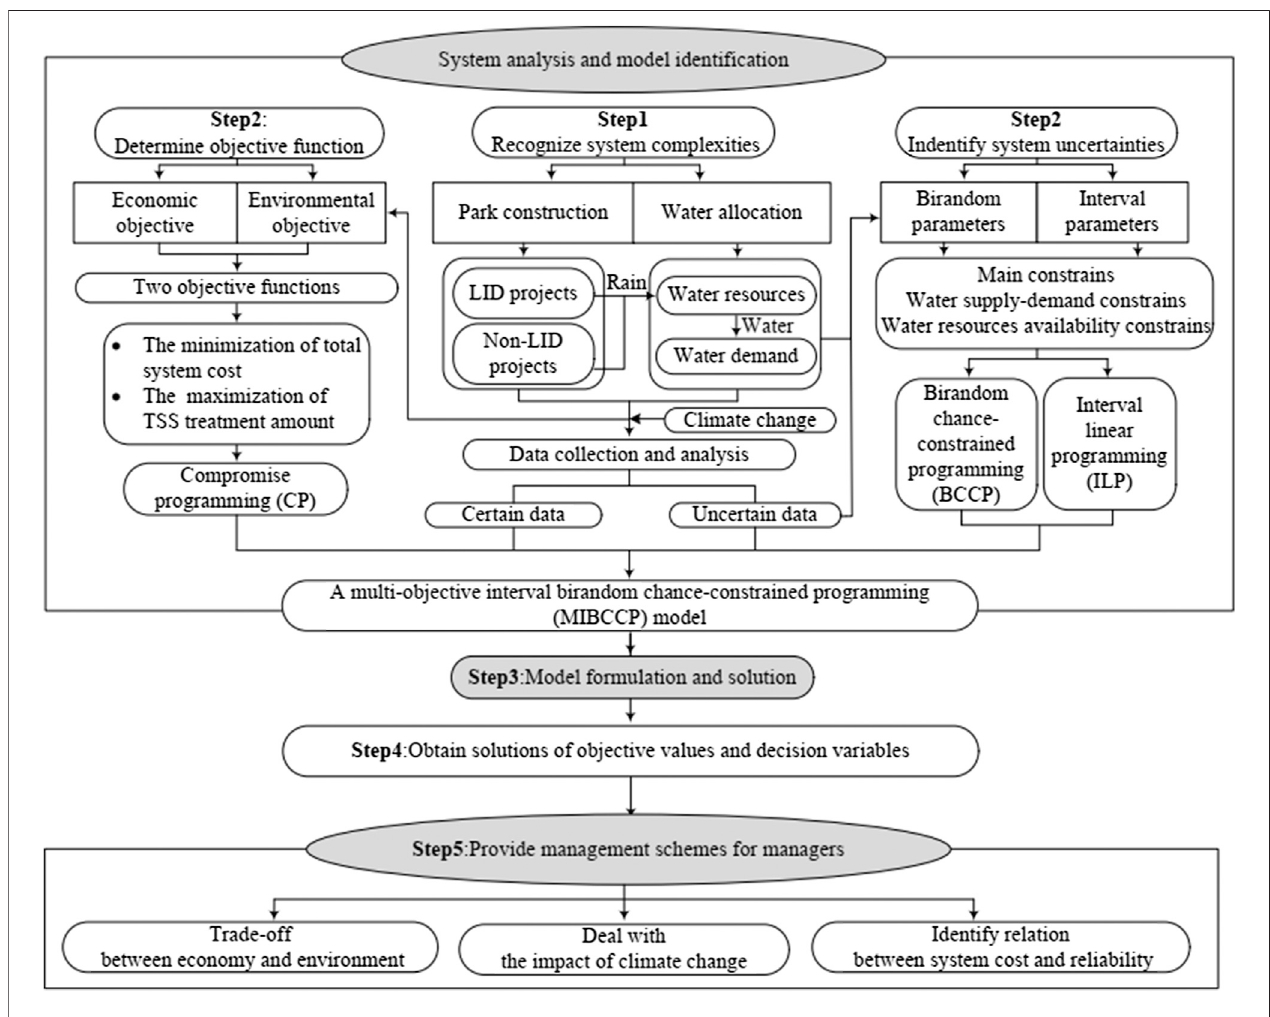
FIGURE 4 | Water supply management diagram for the educational park in